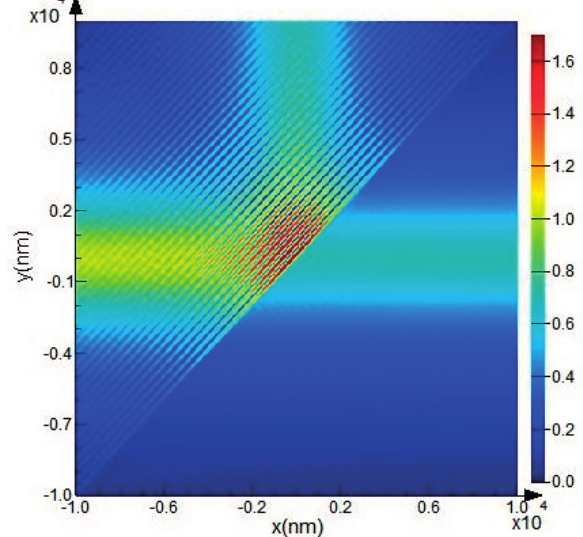
Figure 10. The electric intensity map in a plane 4 μ m above the SiO 2 layer for an asymmetric T-shaped air-trench branch at a wavelength of 1550 nm. The SOI rib waveguide with a large cross section possesses total rib height of 10 μ m, outside rib height of 5 μ m, and rib